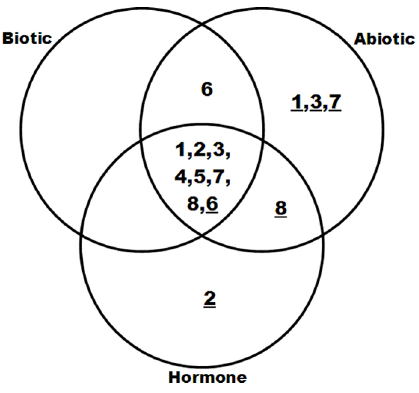
Figure 5. Venn diagram representing the expression profiles of AhGLP genes commonly or specifically regulated by various environmental stimuli, including plant hormones, abiotic stress and/or biotic stress in peanut leaves. 1, 2, 3, 4, 5, 6, 7, 8 were AhGLP1, AhGLP1, AhGLP2, AhGLP3, AhGLP4, AhGLP5, AhGLP6, AhGLP7 and AhGLP8, respectively. The underline numbers indicated down-regulated genes, and the numbers without underlines were up- regulated genes.